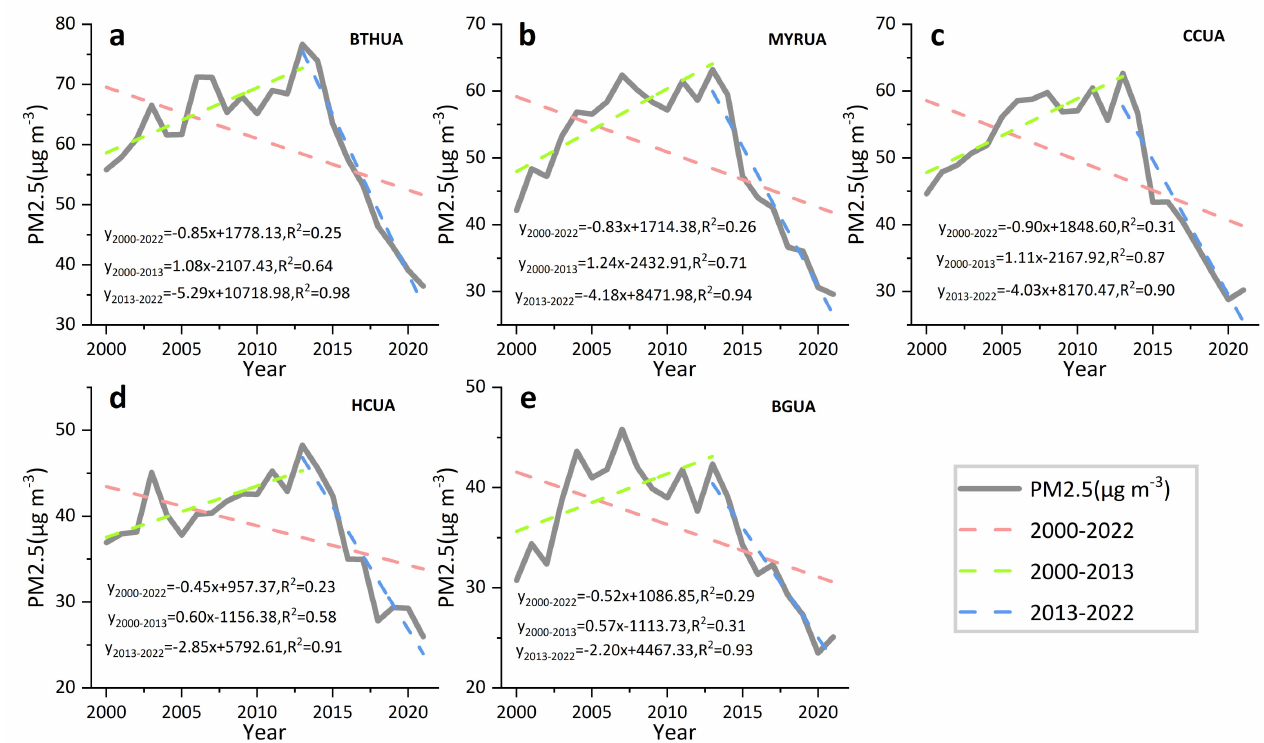
Figure 2. Interannual variation of PM 2.5 concentration at spatial average scale in ( a ) BTHUA, ( b ) MYRUA, ( c ) CCUA, ( d ) HCUA, ( e ) BGUA. The pink, green, and blue dotted lines in the graph represent 2000–2021, 2000–2013, and 2013–2021,